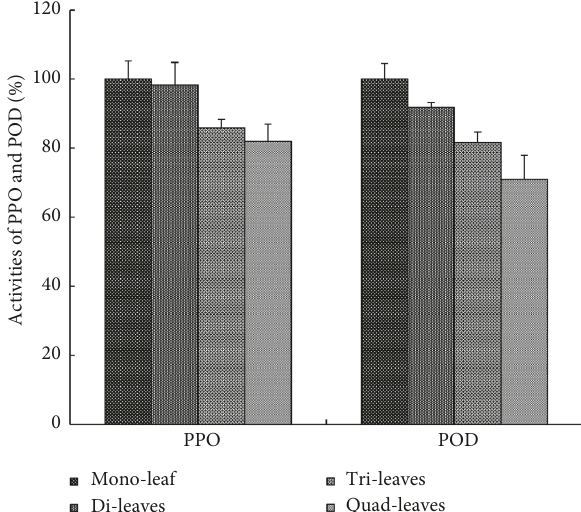
Figure 3: PPO and POD activities of fresh tea leaves with different plucking standards ( n � 3).